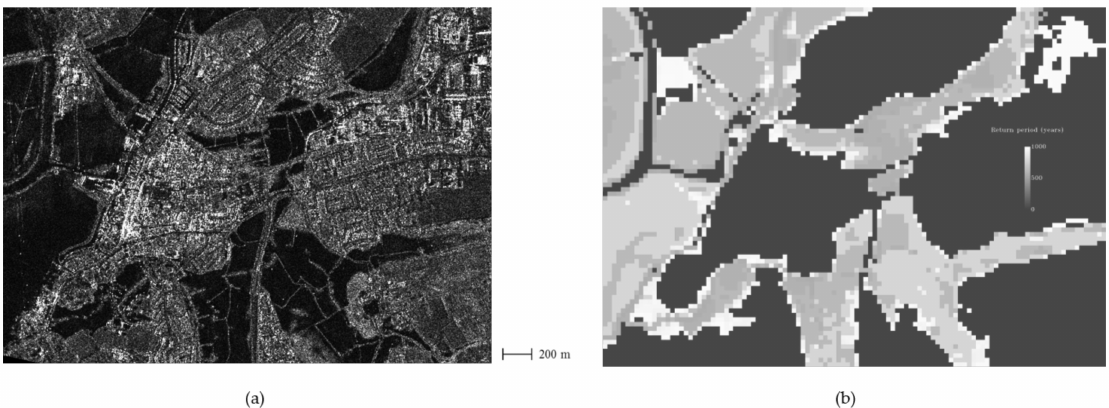
Figure 8. ( a ) TerraSAR-X image showing flooding in the Tewkesbury area on 25 July 2007 (52 ◦ N, 2.2 ◦ W, pixel intensities are DN backscatter values, and dark areas are water, 2.6 × 2 km, © DLR, after [39]), and ( b ) flood return-period map (black areas masked